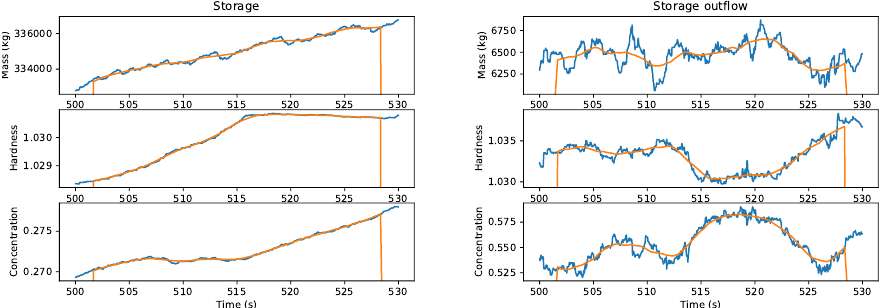
Figure 14. Evolution of the storage average properties over time ( left ) and the predicted feed for the next 30 s ( right ) given the funnel flow zone in Figure 13. A 2 s moving average is included